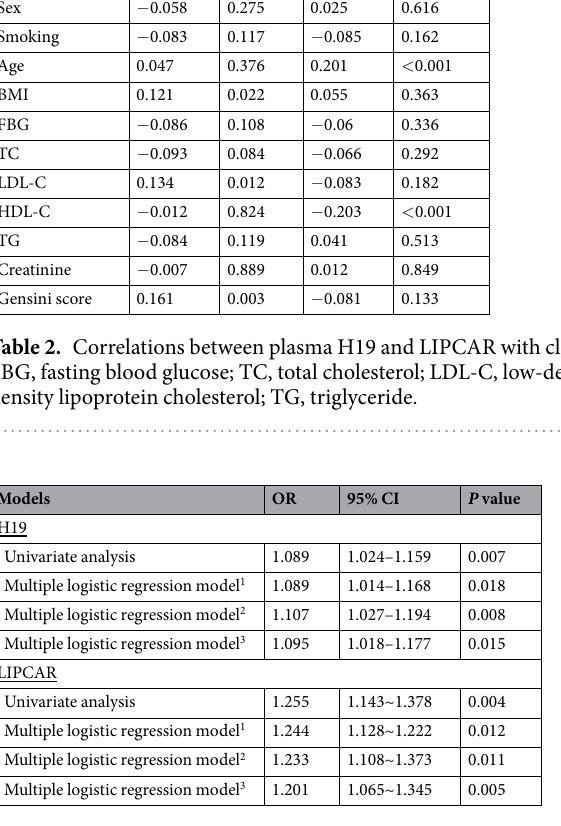
Table 3. Univariate analysis and multiple logistic regression analysis for the risk of CAD. The model 1 included age, gender, BMI, and smoking. The model 2 included age, gender, BMI, smoking, hypertension, and diabetes. The model 3 included age, gender, BMI, smoking, hypertension, diabetes, TC, TG, LDL-C, and HDL-C. OR, odds ratio; CI, confidence interval.